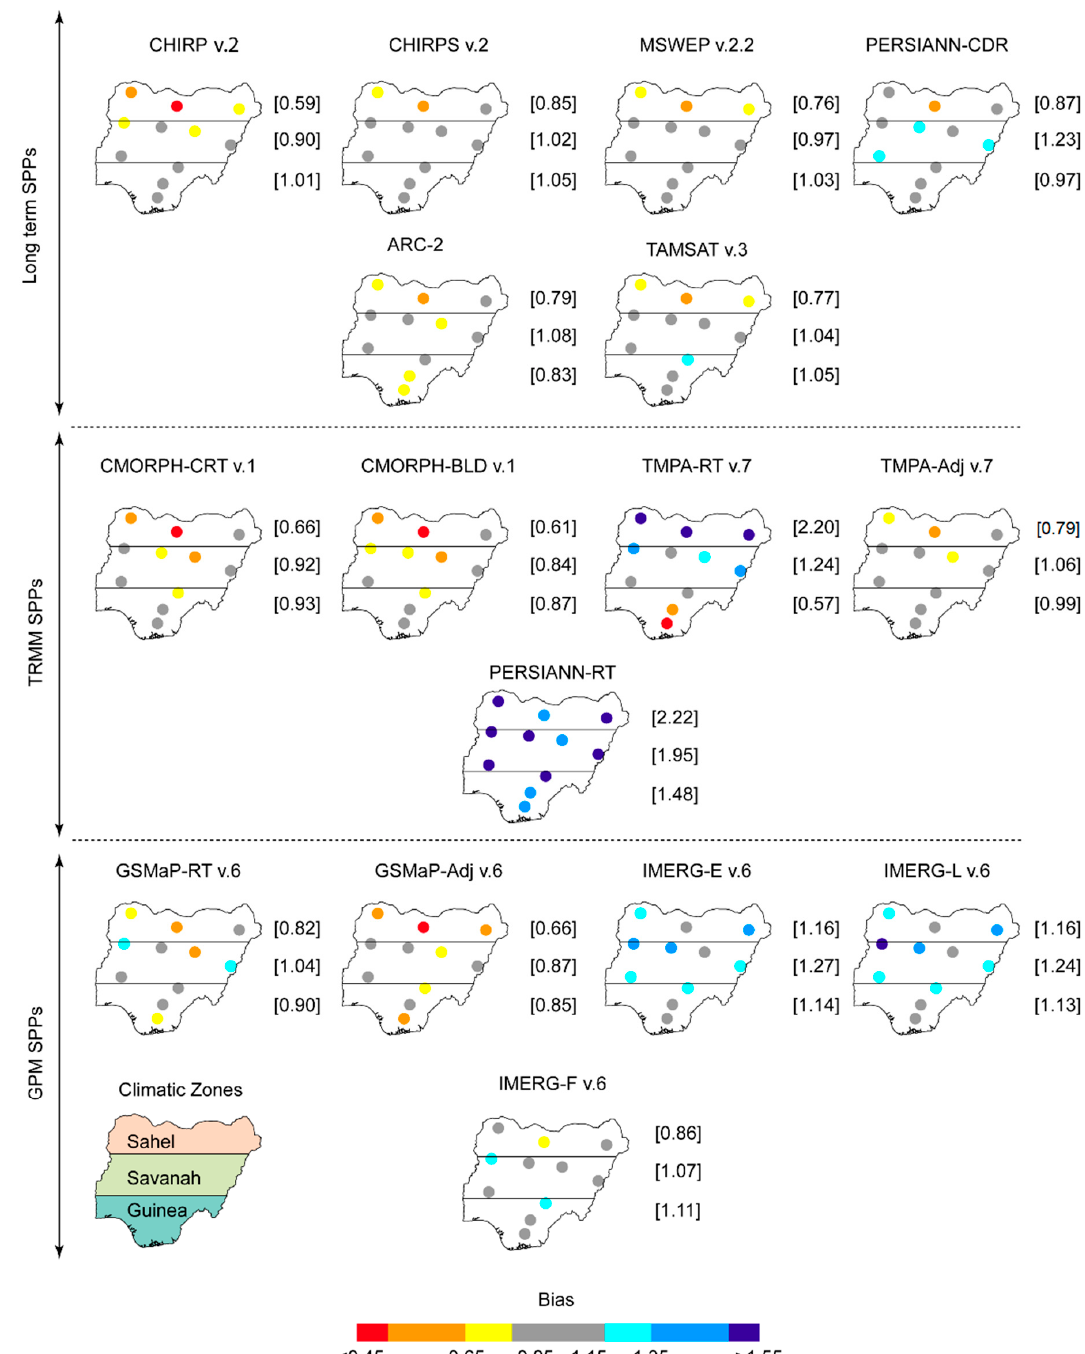
Figure 6. The β values obtained at the grid cell level for all SPPs over the 2000–2012 period. The SPPs are grouped according to their respective categories, and the gauges are separated by the country’s ecological